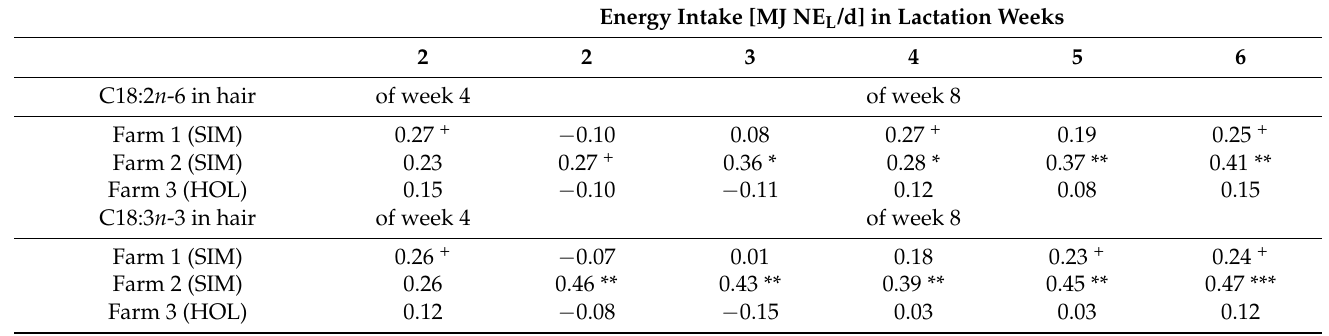
Table 4. Pearson’s correlation coefficients between energy intake [MJ NE L /d] in lactation weeks 2 to 6 corrected for feeding group and lactation number in farm 1 (SIM), farm 2 (SIM), and farm 3 (HOL), and C18:2 n -6 and C18:3 n -3 contents in the hair of weeks 4 and